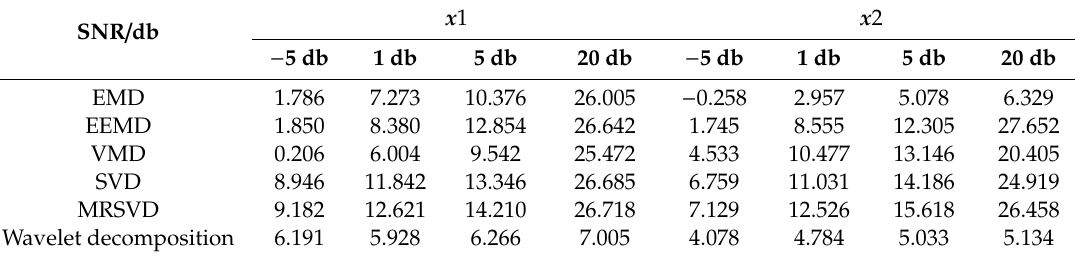
Table 5. MSE of various noise reduction models at di ff erent noise